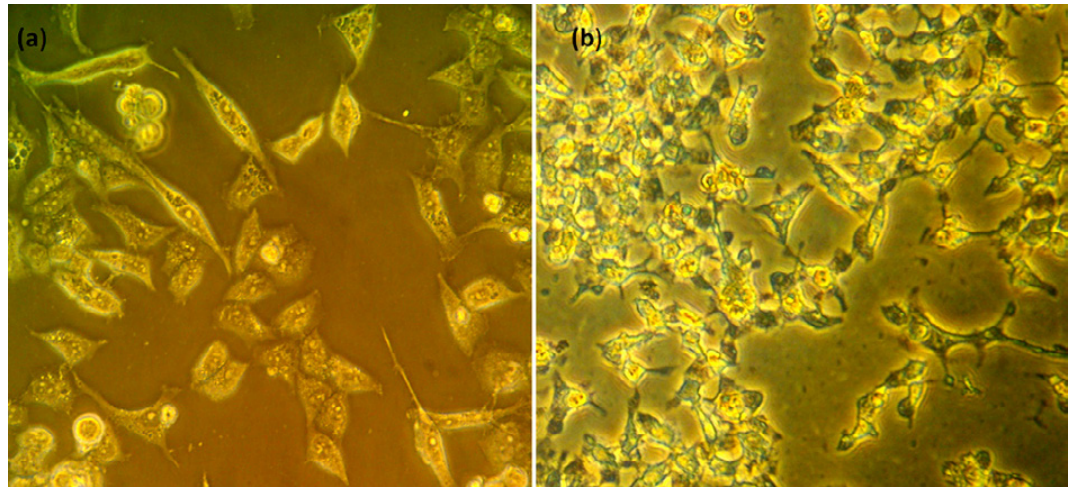
Fig. 5. Follow-up of nanoparticles uptake with Prussian blue staining after 4 h incubation for (a) negative control (complete culture medium) and (b) sample A 60 μg(Fe)/ml.